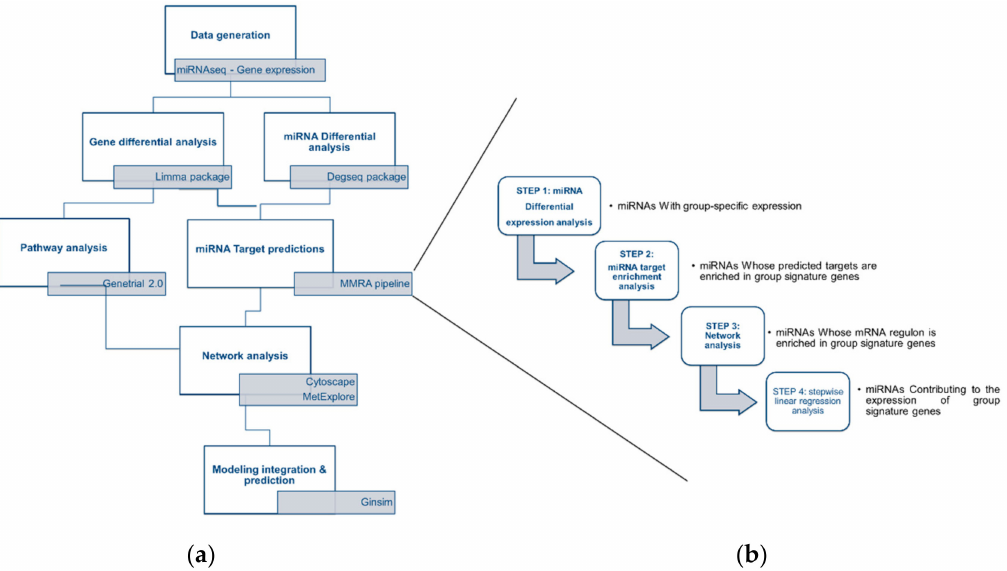
Figure 1. Bioinformatic workflow. ( a ) Bioinformatic analysis of microarray and microRNA-seq data was performed through a series of bioinformatic blocks: di ff erential expression analysis, prediction of miRNA targets, analysis and visualization of interaction networks and computational modeling to predict cellular metabolic behaviors and phenotypes. ( b ) The four-step MMRA (microRNA Master Regulator Analysis) pipeline was followed to obtain the putative miRNA targets and included miRNA target enrichment analysis, network analysis and stepwise linear regression